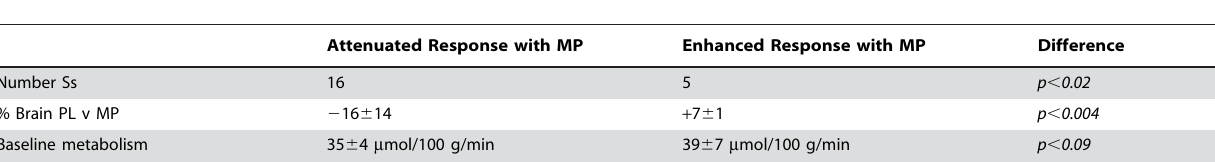
Table 1. Differences in brain metabolic activation to the task (percent change) when given with MP when compared with placebo (PL) between subjects in whom MP attenuated brain activation versus those in whom it enhanced activation along with their baseline metabolic